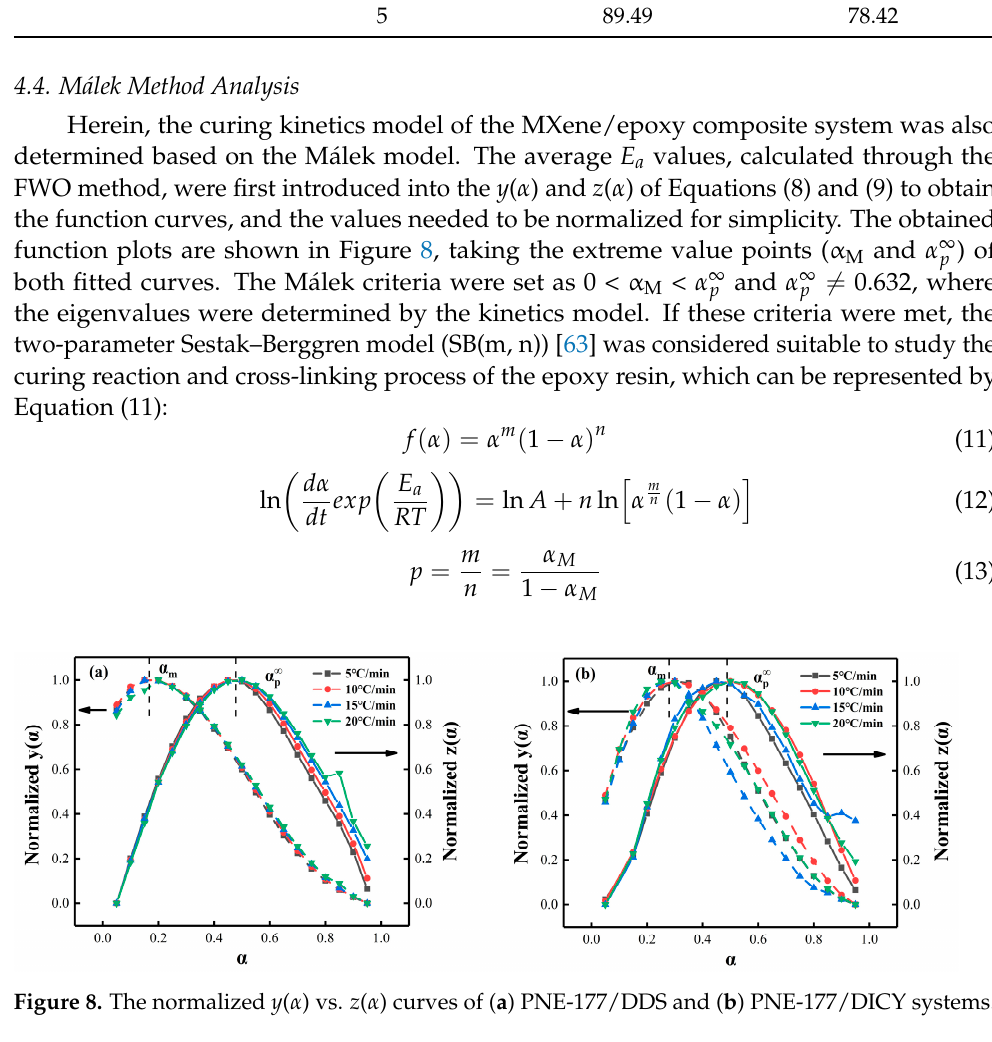
Figure 9. The comparison between experimental and simulated DSC curves of ( a ) PNE-177/DDS and ( b ) PNE-177/DICY systems based on SB (m, n)